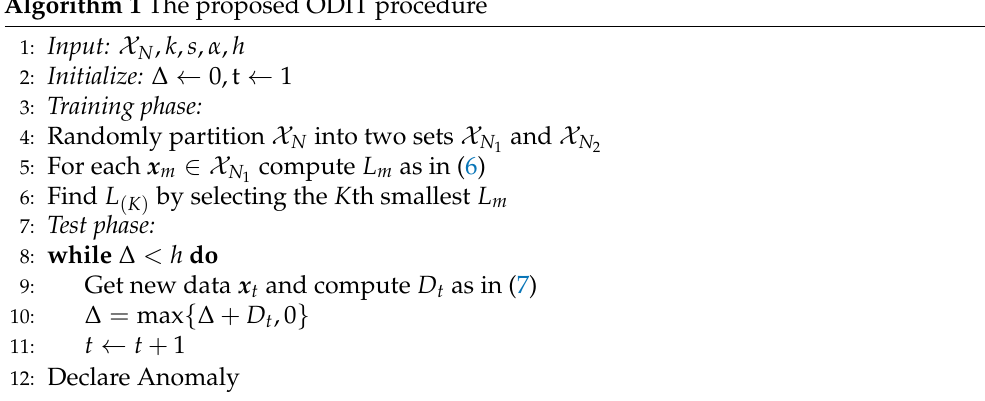
Algorithm 1 The proposed ODIT